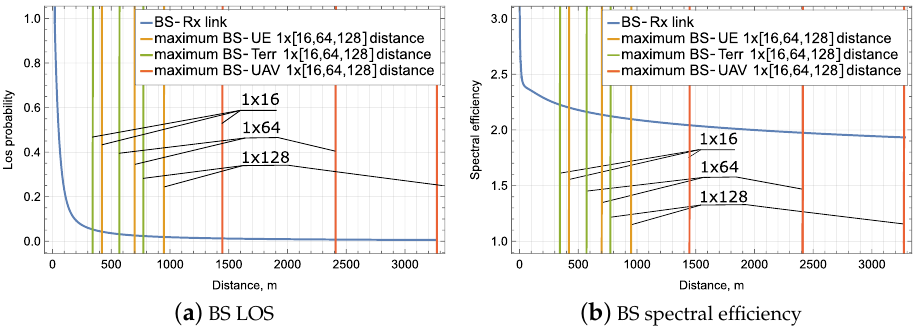
Figure 2. LOS and spectral efficiency as a function of